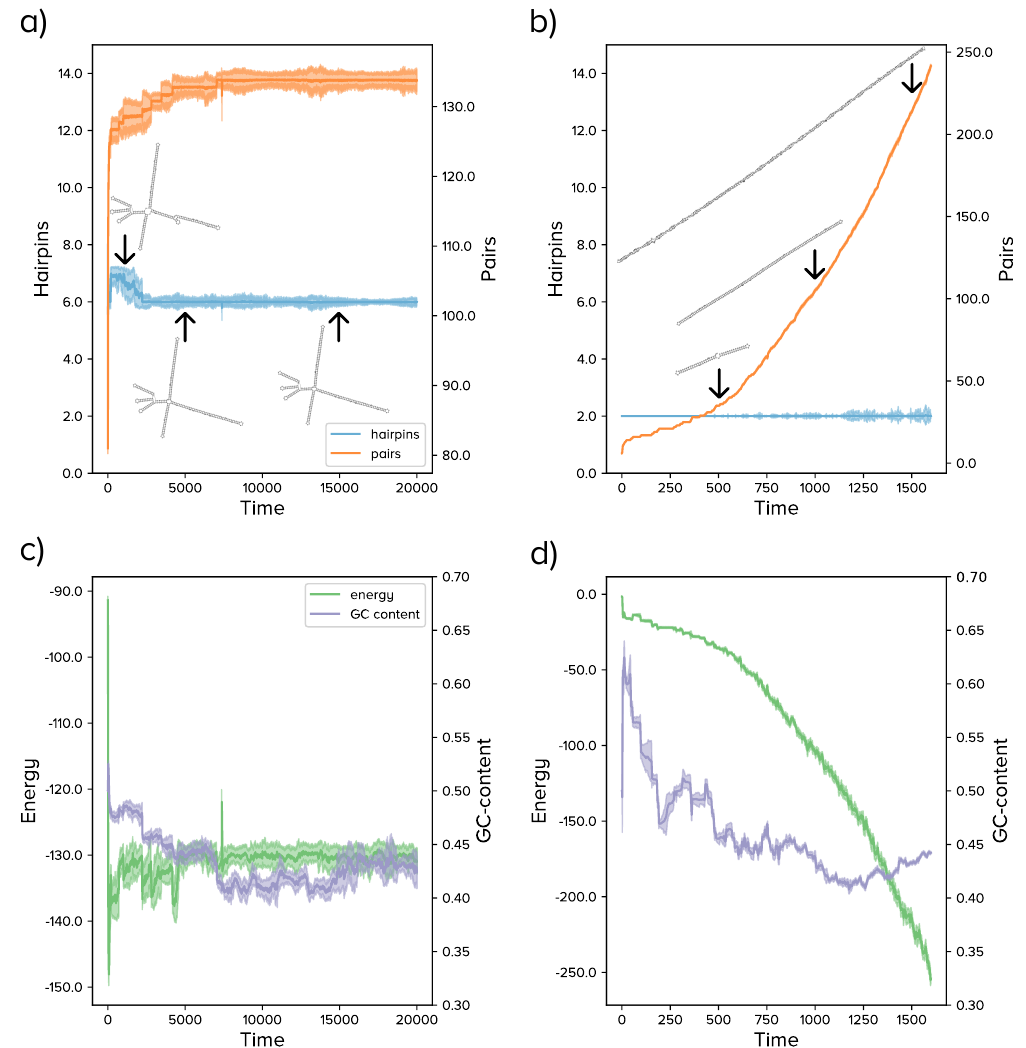
Figure 2. Evolutionary dynamics of RNA populations with fixed ( a , c ) and variable ( b , d ) length. In the former case, simulations start with a random sequences of length 300 nt; in the latter, of length 30 nt. ( a ) The number of hairpins decreased initially, but rapidly froze around six; the number of base pairs increased until a value near the maximum possible for that number of hairpins. The most abundant structure is shown at three different time points, as indicated by arrows. ( b ) As in ( a ), for sequences growing in length. ( c ) Dynamics of energy and G + C content for the same run shown in ( a ). ( d ) As in ( c ), for the run shown in ( b